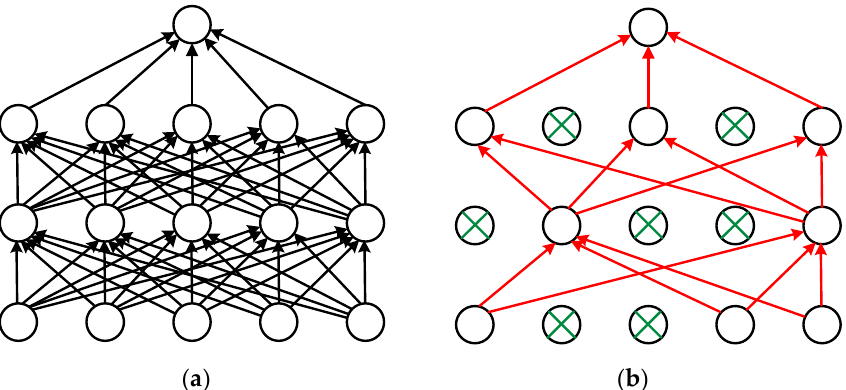
Figure 3. ( a ) is the standard network, and ( b ) is applying dropout. This time the green neurons were not involved in the training.